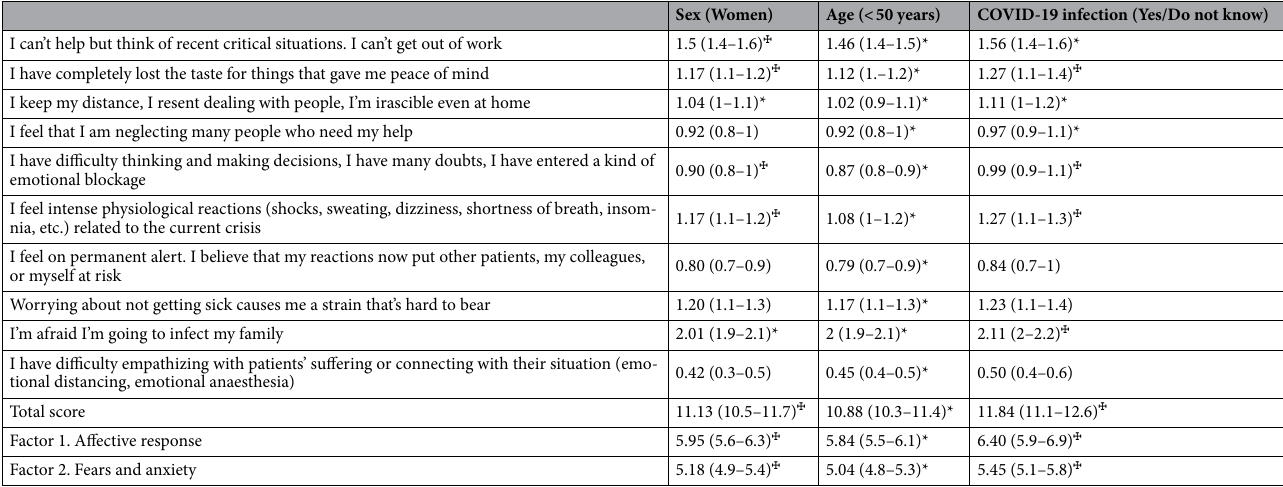
Table 3. Univariate analysis. *Stands for p value < 0.05. ☩ Stands for p value < 0.001. Scores from 0 to 3 points on each of the items on the scale. Scores from 0 to 30 in total on the scale. Scores from 0 to 18 in factor 1. Scores from 0 to 12 in factor 2.